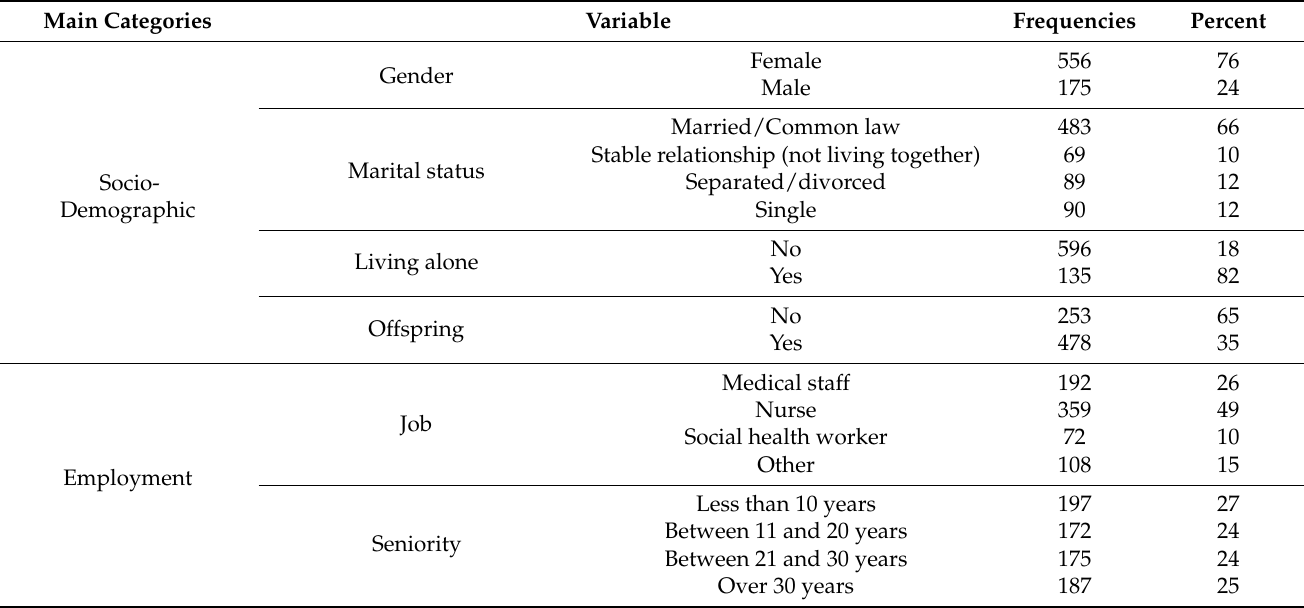
Table 1. Study sample characteristics ( n =